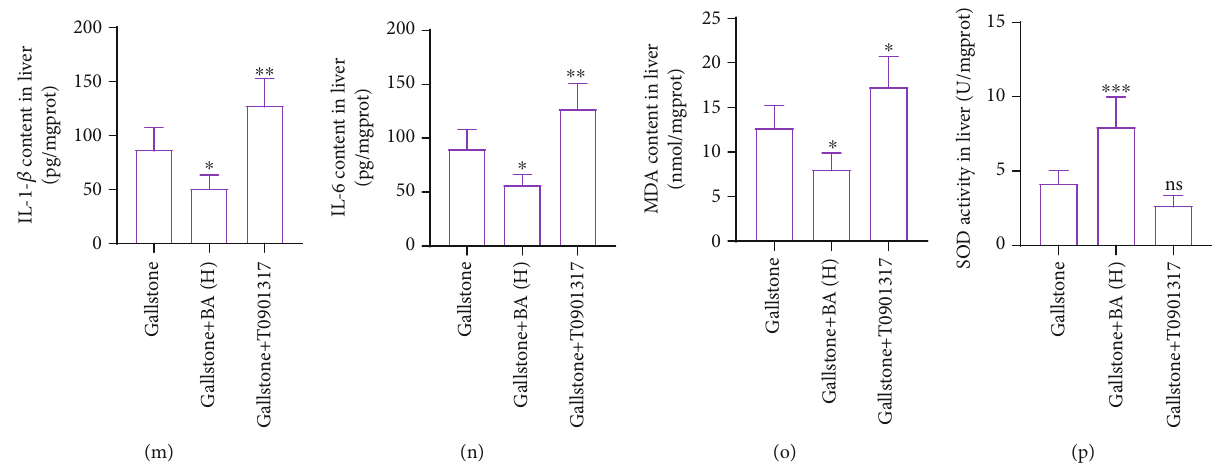
Figure 6: Baicalin regulated cholesterol metabolism and lithogenic diet-induced hepatic damage by inactivating LXR α . (a – c) Real-time PCR was used for detection of mRNA levels of CYP7a1 (a), CYP8b1 (b), and LXR α (c) in the liver of mice with a lithogenic diet and baicalin or LXR α agonist T0900307. (d) The protein levels of CYP7a1, CYP8b1, ABCG5, ABCG8, and LXR α were measured by western blot. (e – i) Quantitative analysis of CYP7a1 (e), CYP8b1 (f), ABCG5 (g), ABCG8 (h), and LXR α (i) of immunoblotting bands in (d). (j, k) The enzymatic activity of ALT (j) and AST (k) in serum. (l – n) The content of in fl ammatory factors TNF- α , IL-1 β , and IL-6 in the liver was detected by ELISA. (o) The MDA content in the liver. n = 6 . (p) The SOD activity in the liver. ∗ p < 0 : 05 , ∗∗ p < 0 : 01 , and ∗∗∗ p < 0 : 001 . ns: no signi fi cance; BA(H): 100 mg/kg